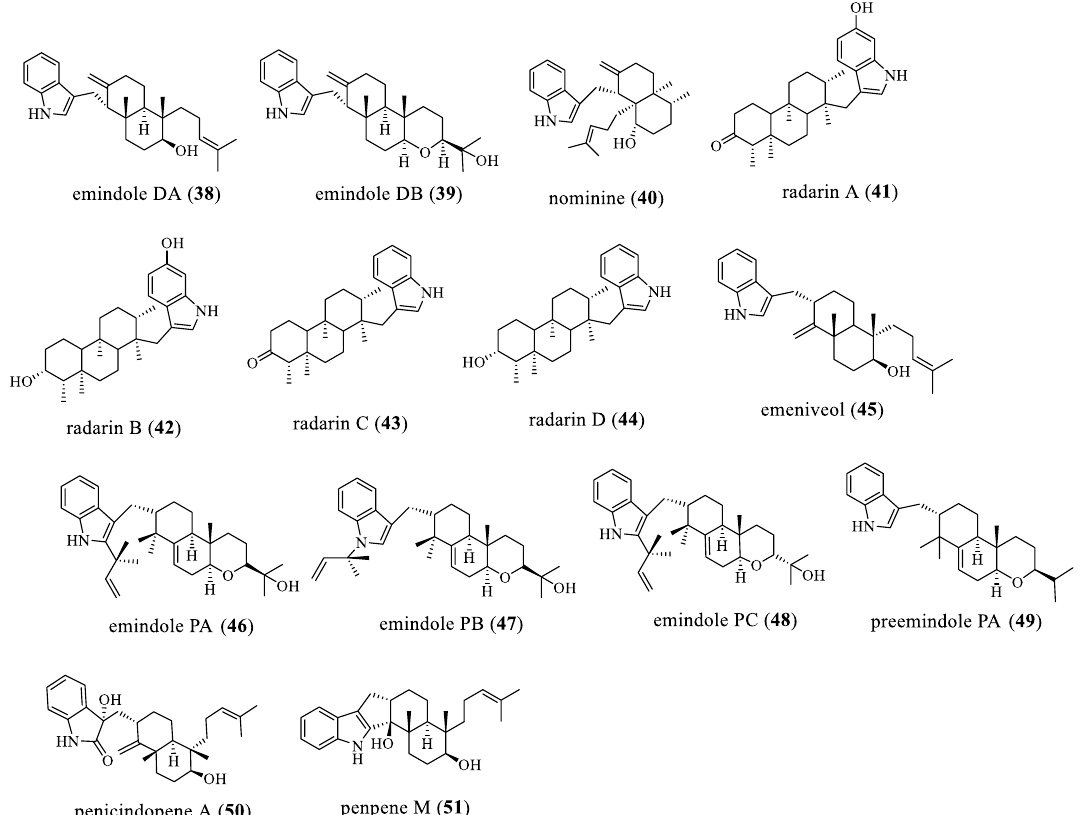
Fig. 3 Chemical structures of emindole DA series